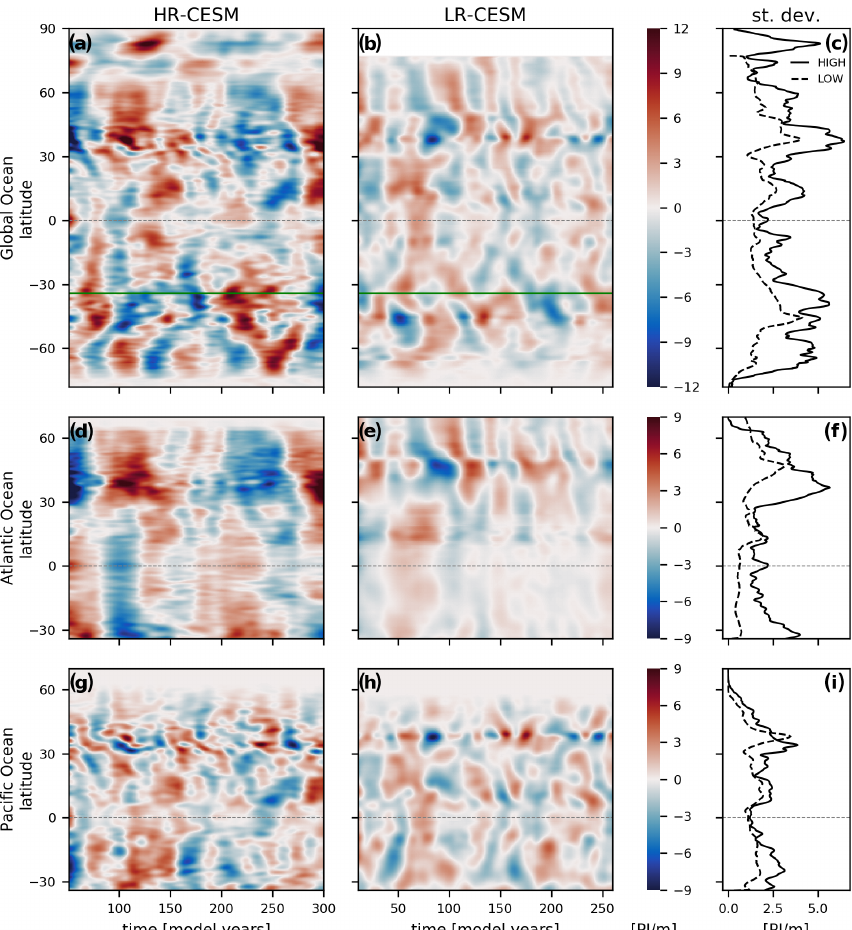
Figure 6. The 13-year low-pass-filtered zonally and depth-integrated OHC anomalies (OHC v (t,y) of Eq. 5) as Hovmöller diagrams of the HR- (left) and LR-CESM simulations (center), respectively. The top row shows the globally integrated OHC anomaly (which includes the Southern Ocean signal south of 34 ◦ S, demarcated with the green line in the first row), while the lower rows show the individual ocean basins. The Equator is marked with a thin dashed line. The right column shows the standard deviation in time of the zonally and depth-integrated OHC (solid: HR-CESM; dashed: LR-CESM). The LR-CESM latitude values are averaged along the grid x coordinate, such that north of 60 ◦ N they do not exactly represent the true latitudes. Note the different color scale ranges of each row with units of PJm − 1 = 10 15 Jm − 1